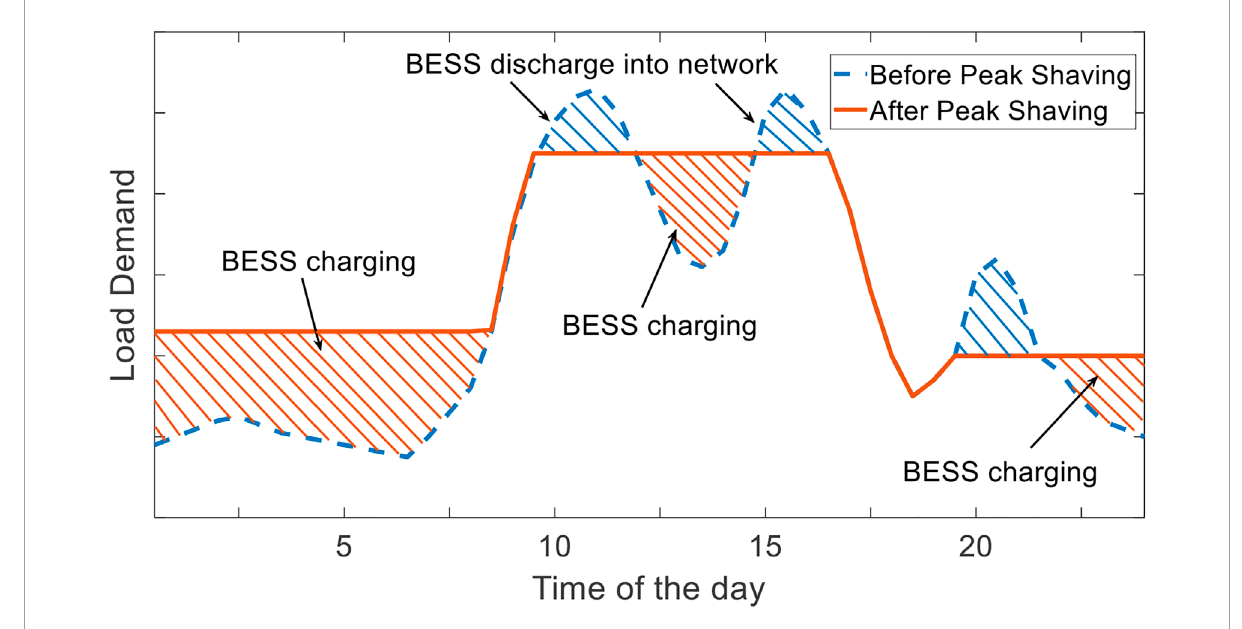
FIGURE 5 Typical application of BESS for peak